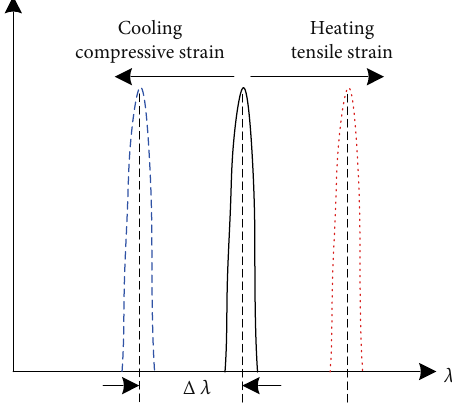
Figure 4: Wavelength changes corresponding to temperature and strain [42].